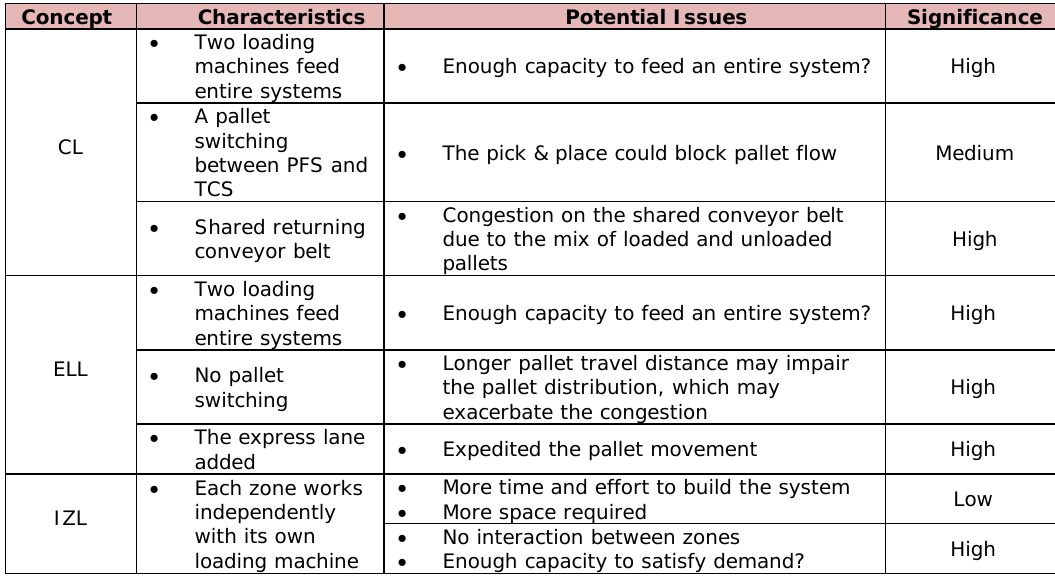
Table 2. “Qualitative concept comparison”. Sources: